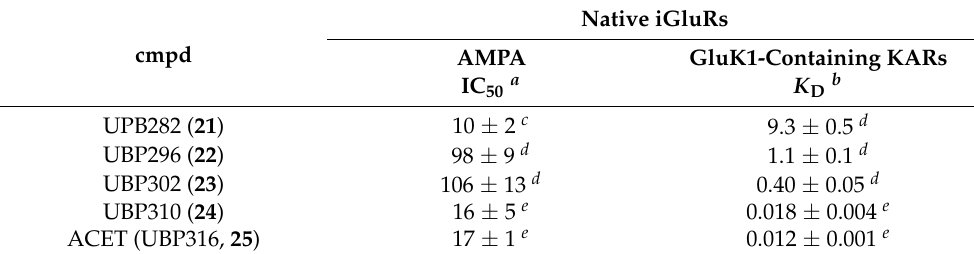
Table 3. Activity of willardiine-derived antagonists at native AMPA and KA receptors in functional electrophysiological assays (all values in µ